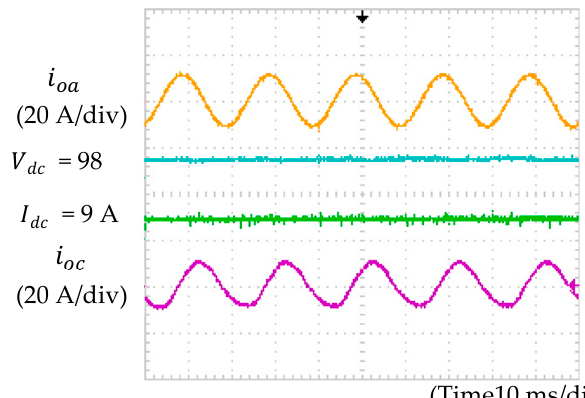
Figure 17. The current and voltage measurements waveforms of DC fast charging.